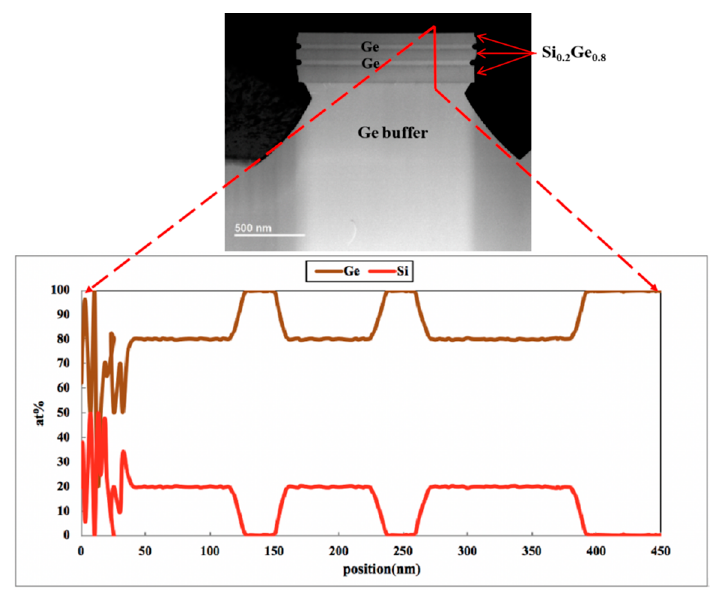
Figure 9. TEM image of etching profile and EDS analysis with line scanning of Si and Ge in vertical orientation of the Ge buffer/Si 0.2 Ge 0.8 /Ge stack structure.